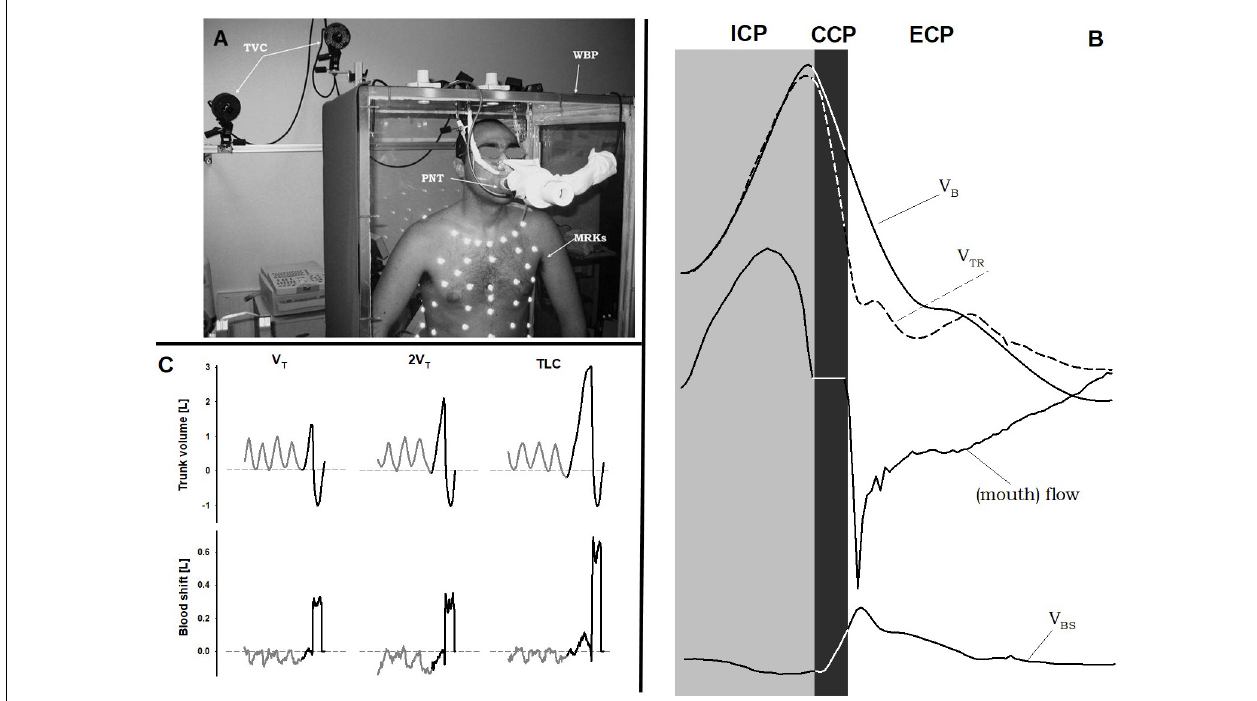
FIGURE 1 | Double plethysmograph, traces and protocol. (A) Experimental set-up: the transparent whole body plethysmograph (WBP), the infra-red TV cameras (TVC), and the markers (MRKs) of optoelectronic plethysmography, and the pneumotacograph (PNT) to measure the flow at the mouth. (B) Time courses of body (V B ) and trunk (V TR ) volumes, flow measured at the mouth, and blood shift (V BS ) during a single maximal voluntary cough. Gray area: inspiratory cough phase (ICP); black area: compressive cough phase (CCP); white area: expulsive cough phase (ECP). (C) Representative case of trunk volume changes (top panels) and blood shift (bottom panels) during spontaneous breathing (gray) and a single cough maneuver (black) at each operating lung volume: a tidal volume above functional residual capacity (V T , left panels), total lung capacity (TLC, right panels), and an intermediate volume (2V T , middle panels). V BS was calculated as the difference between trunk and body volume variations. Positive values of V BS indicate blood shifts occurring from the thorax to the extremities and vice versa. Written informed consent was obtained for the publication of the (A)